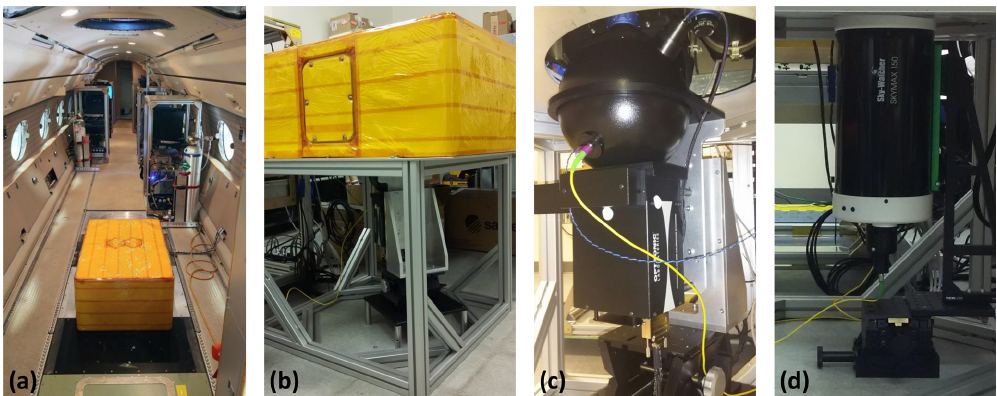
Figure 4. During flight (a) and calibration (b) , the instrument is mounted in the same orientation and controlled to the same temperature by the yellow thermal housing. An integrating sphere (c) is used to perform non-uniformity and ISRF calibration, while a collimator (d) is used for stray-light